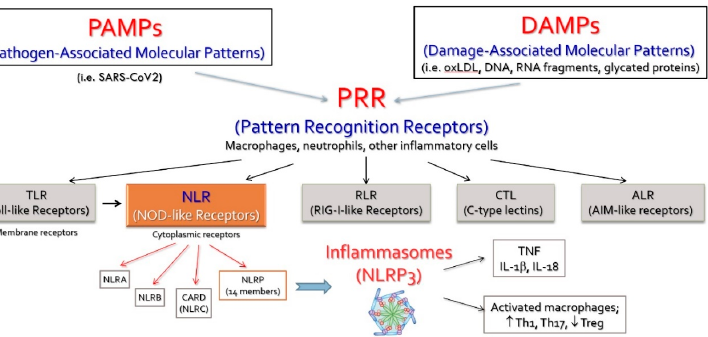
Figure 1. The systemic effects of NLRP3 caspase ‐ 1 ‐ mediated interleukin activation. Interleukin ‐ 6 generated by the potent stimulus of IL ‐ 1b leads to secretion of acute ‐ phase proteins in the liver, induces endothelial dysfunction and activates smooth muscle cells in arterial media. IL—interleu ‐ kin; ox ‐ LDL—oxidated LDL molecule; CRP—C ‐ reactive protein; PAI ‐ 1—plasminogen activator in ‐ hibitor ‐ 1. (Reproduced with permission, [31]) The NLR family consists of fourteen different molecules that have been named as “inflammasomes” [32]. The most studied inflammasome is NLRP3. It exists in the cyto ‐ plasm as an inactive monomer (Figure 2). Its intracellular expression is increased by an nuclear factor kappa ‐ light ‐ chain ‐ enhancer of activated B cells (NF ‐ kB) ‐ mediated mecha ‐ nism after activation of TLRs by DAMPs or PAMPs and/or by Tumor necrosis factor (TNF)receptors stimulated by TNF ‐ alpha (the “priming” process). Subsequently, NLRP3 monomers are oligomerized in the active NLRP3 inflammasome in the “triggering” pro ‐ cess (Figure 3) [33]. As far as DAMPs and PAMPs are structurally extremely different, they could not directly interact with the NLRP3 monomers in the cytoplasm to set off their oligomerization. Different activation pathways are investigated for NLRP3 triggering: ly ‐ sosomal lysis, mitochondrial generation of reactive oxygen species (ROS), calcium inflow or potassium outflow [34]. Figure 2. The molecular structure of the inflammasome. This is a large complex multimeric protein consisting of oligomerized NLRP. This consists of a central NOD immune receptor, a leucine ‐ rich repeat (LRR) domain acting as an activation sensor and an effector domain, either a pyrin ‐ contain ‐ ing (PYD) or a caspase activation and recruiting domain—CARD. When activated, the effector do ‐ main of NLRP interacts with an adaptor protein (ASC) via a CARD molecule and activates pro ‐